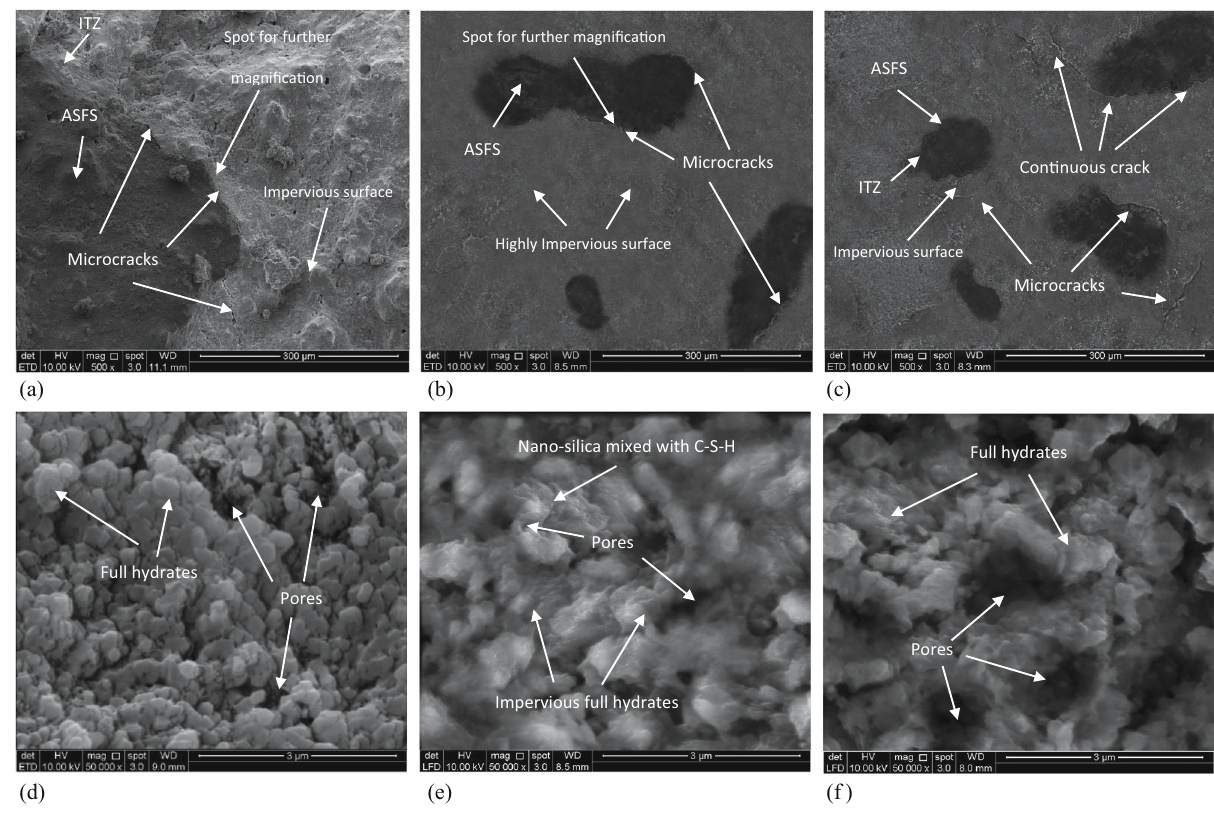
Figure 13: SEM images of SSHWC at 28 days curing age. ( a ) S0.0 SSHWC at 500 × [ 13 ] . ( b ) S3.0 SSHWC at 500 × . ( c ) S5.0 SSHWC at 500 × . ( d ) S0.0 SSHWC at 50,000 × [ 13 ] . ( e ) S3.0 SSHWC at 50,000 × . ( f ) S5.0 SSHWC at 50,000 ×